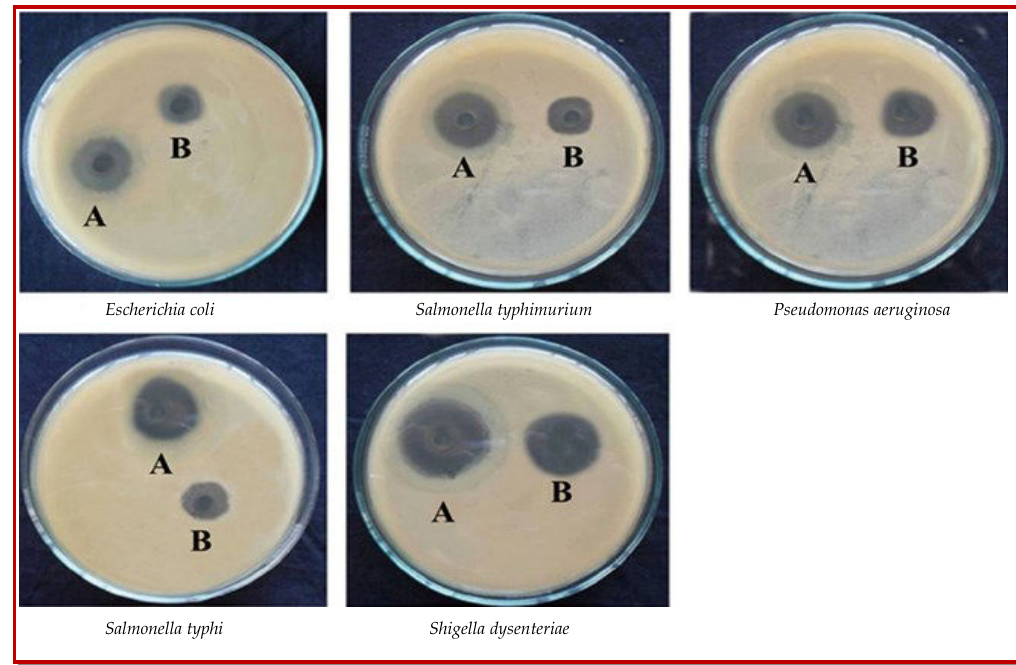
Figure 3: The evaluation of antibacterial effect of seneciolactone against five bacterial strains using disk diffusion assay. A and B represent zone of inhibition due to vancomycin and seneciolactone